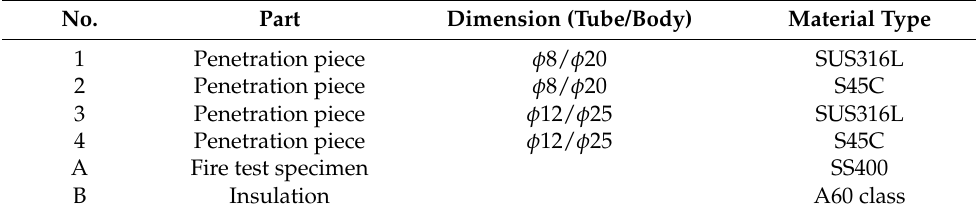
Figure 4. Configuration of the fire test specimen. Table 1. Detail specification of the analysis model. Table 1. Detail specification of the analysis model.